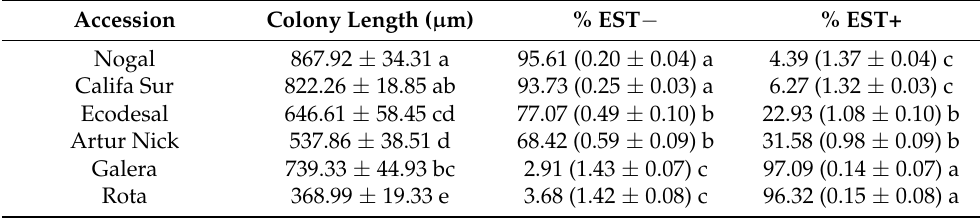
Figure 5. ( A ) Examples of established P. striiformis microcolonies without necrosis (EST − , upper panel) and ( B ) with necrosis (EST+, lower panel). Left panels show 4 × images with delimited microcolonies magnified at 10 × in the right panels. Scale, 100 µ m. Table 3. Analysis of the colony length of established P. striiformis microcolonies and their distribution relative to total observed established microcolonies in six selected bread wheat accessions 1